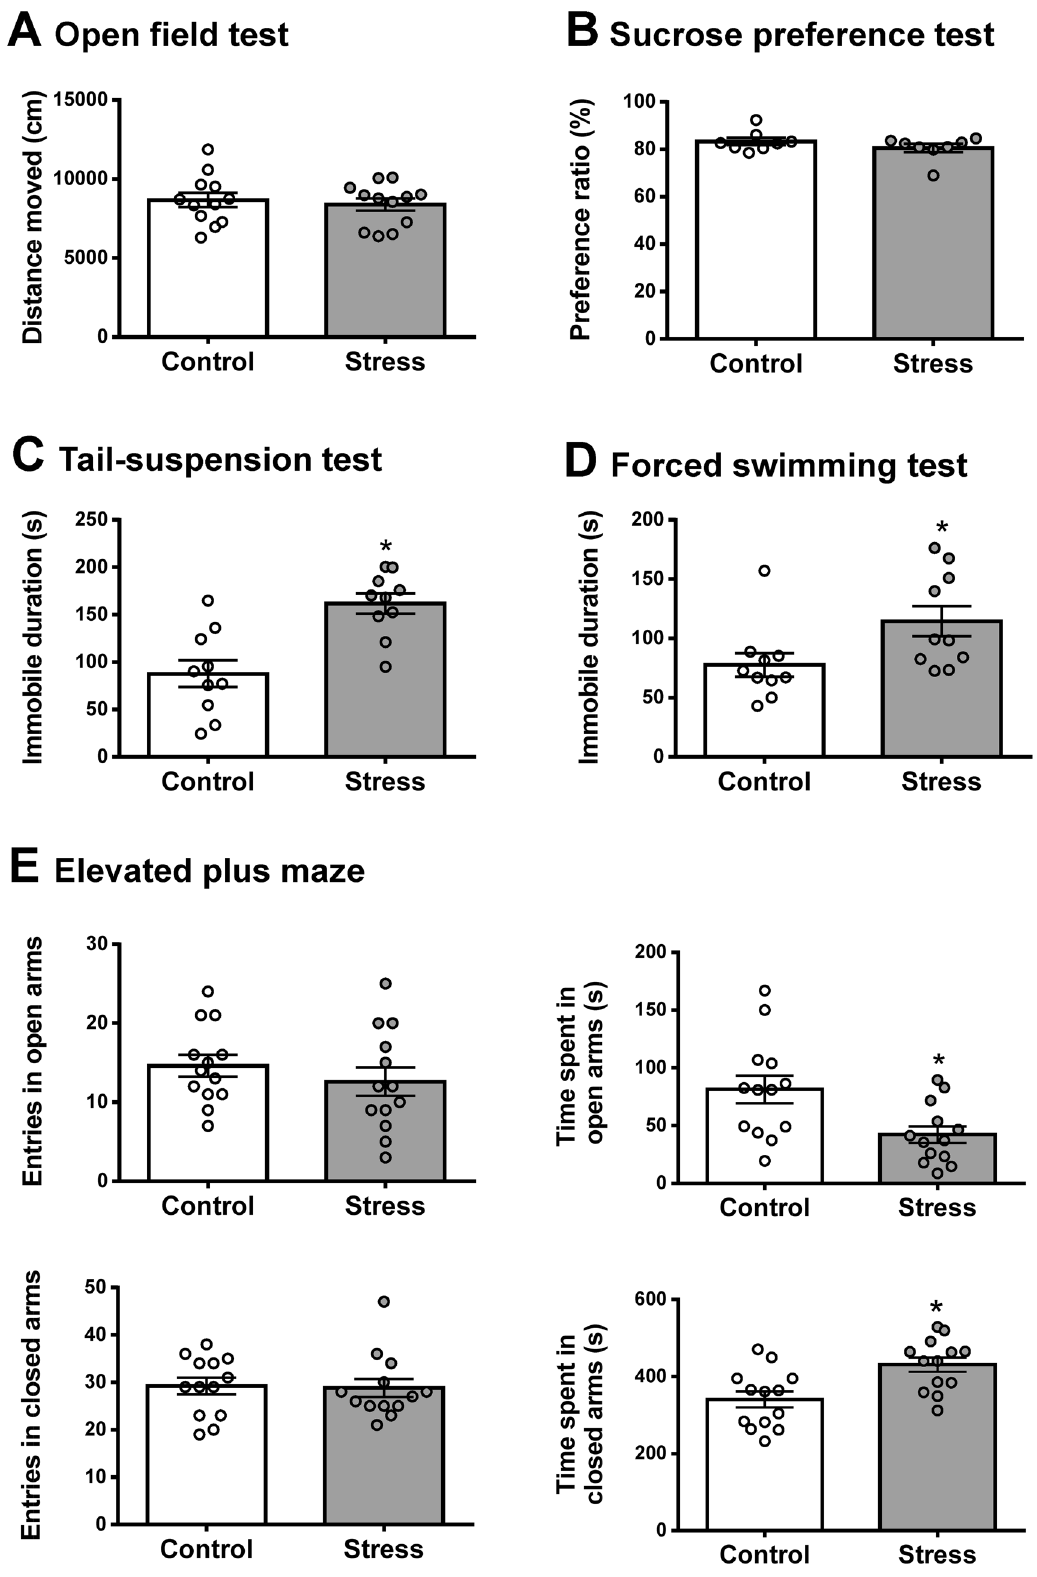
Figure 2. Juvenile SDS induced depression- and anxiety-like behaviors. The behaviors of control and juvenile SDS mice (stress) in open field ( A ), sucrose preference ( B ), tail suspension ( C ), forced swimming ( D ) and elevated plus maze ( E ) tests. Data are presented as the mean ± SEM (n = 8–13 mice per group). * p < 0.05 compared with the control